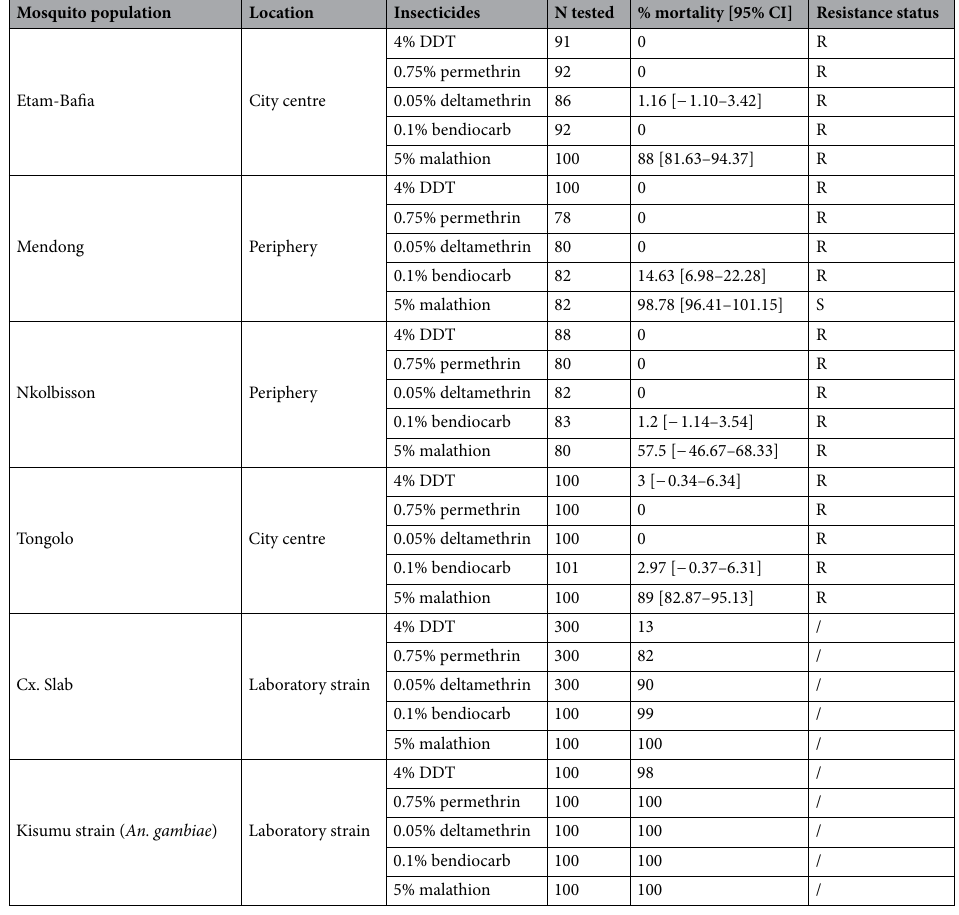
Table 1. Susceptibility level of four Culex quinquefasciatus populations to 4% DDT, 0.75% permethrin, 0.05% deltamethrin, 0.1% bendiocarb and 5% malathion. R : resistant, S :